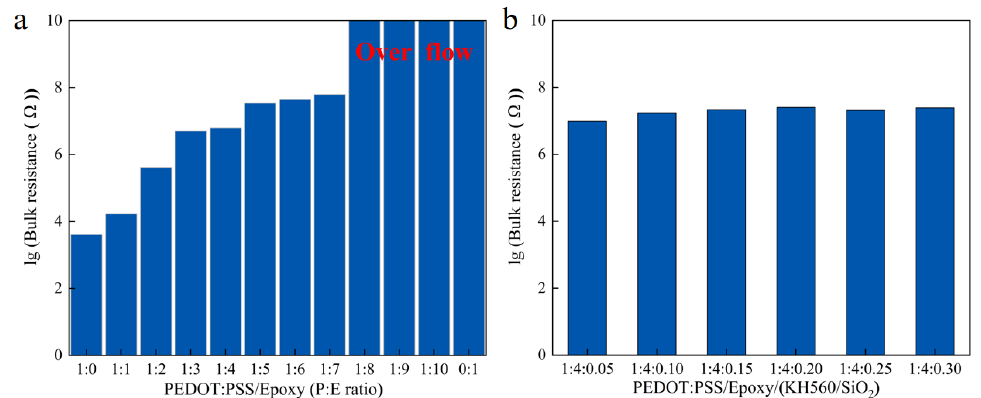
Figure 10. Bulk resistance of PEDOT:PSS/epoxy ( a ) and PEDOT:PSS/epoxy/(KH560/SiO 2 ) ( b ) coat- ings.